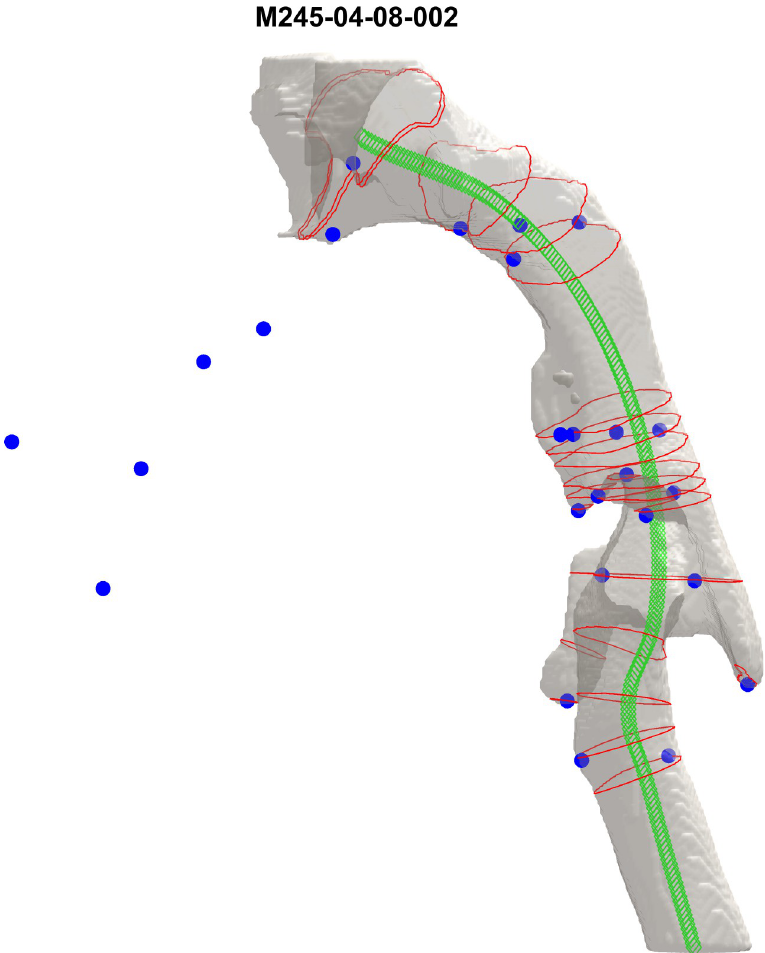
Fig 2. 3D airway model (choanae to trachea) of a 4-year 8-month old typically developing male as visualized in MATLAB. Blue dots represent the 26 anatomic landmarks listed in Table 4. The centerline is shown in green, and CSAs closest to each of the anatomic landmarks are shown in